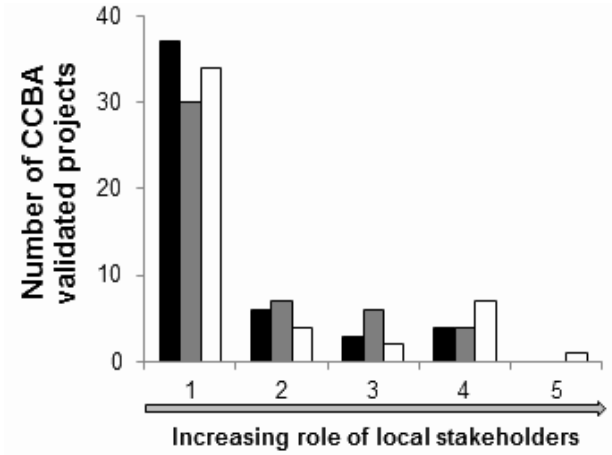
Fig. 4 . Involvement of local stakeholders in monitoring forest biomass (black), biodiversity (shaded), and livelihoods (white) in forest carbon projects validated by the Climate, Community and Biodiversity Alliance (CCBA) (up to April 13, 2012) ( n = 50 forest carbon schemes). The degree of involvement of local stakeholders increases from left to right along the x-axis: 1. no involvement of local stakeholders in monitoring; 2. local stakeholders assist in, or conduct parts of, monitoring but professional foresters are actively involved in on-the-ground monitoring activities; 3. local stakeholders conduct all on-the-ground monitoring themselves but reporting and analysis are done by professional foresters; 4. local stakeholders conduct all on- the-ground monitoring and report the data to a central unit independently, and/or actively participate in the design and implementation phase of the monitoring scheme, and professional foresters conduct the analysis of the monitoring data; 5. local stakeholders participate in the design and implementation phase of the monitoring scheme, conduct all on-the-ground monitoring, and report and analyze all on- the-ground data themselves.